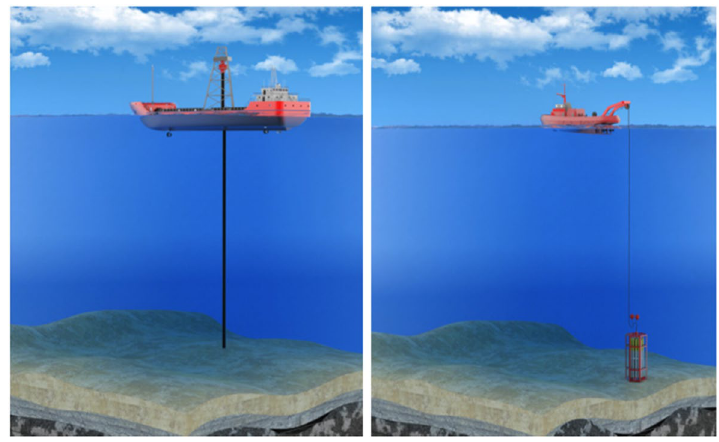
Fig. 1 The main methods used for seafloor coring [13,